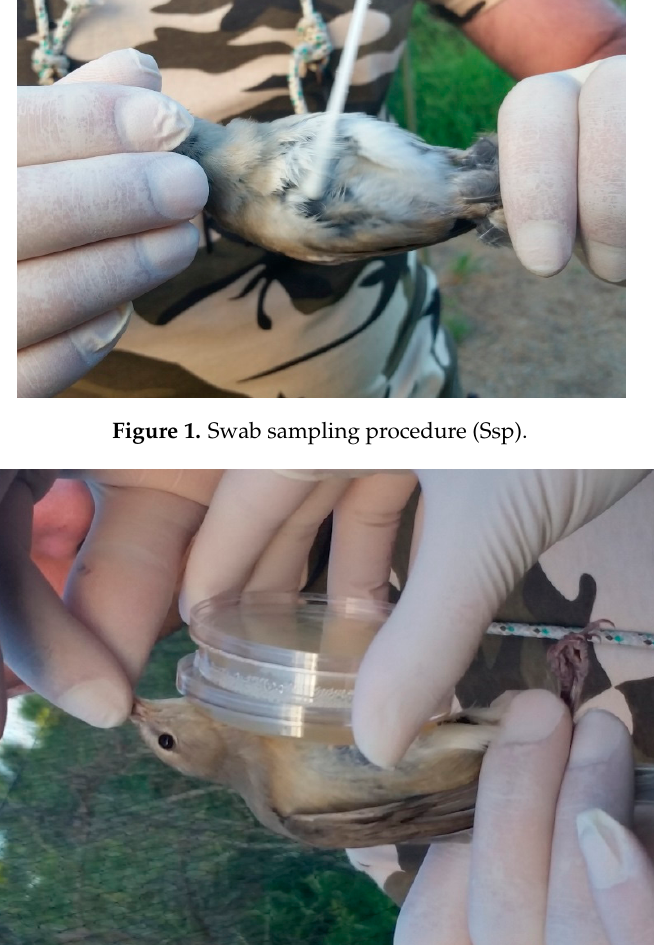
Figure 2. RODAC sampling procedure (Rsp). 103